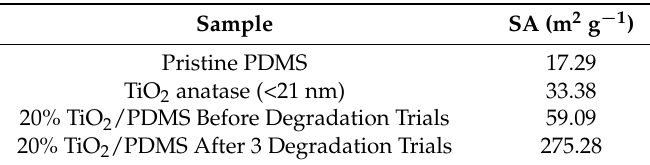
Table 2. Surface area (SA) per unit mass for pristine PDMS beads (from a previous paper [28]), anatase TiO 2 , and 20%-TiO 2 /PDMS. Addition of TiO 2 to the beads increases the surface area of the bead. The increase compared to the pure TiO 2 is an effect of the difference in density between TiO 2 and polymer